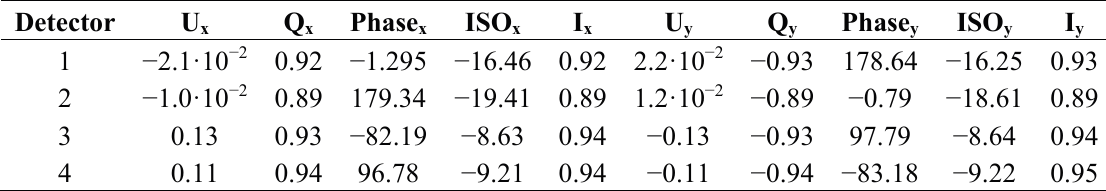
Figure 5. First polarimeter example: Detected signals resulting from the phase-adjustment process with an x -axis polarized input signal ( a ) and measurement process with a y -axis polarized input signal ( b ). Table 3. Parameters calculated from the detected signals shown in Figure 5 (Phase in Deg. and ISO in